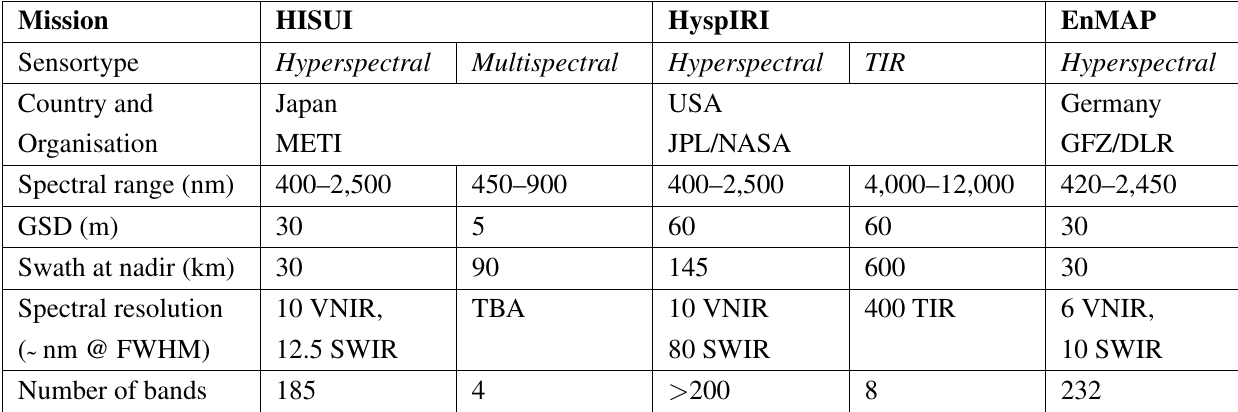
Table 1. Technical parameters of upcoming spaceborne hyperspectral missions